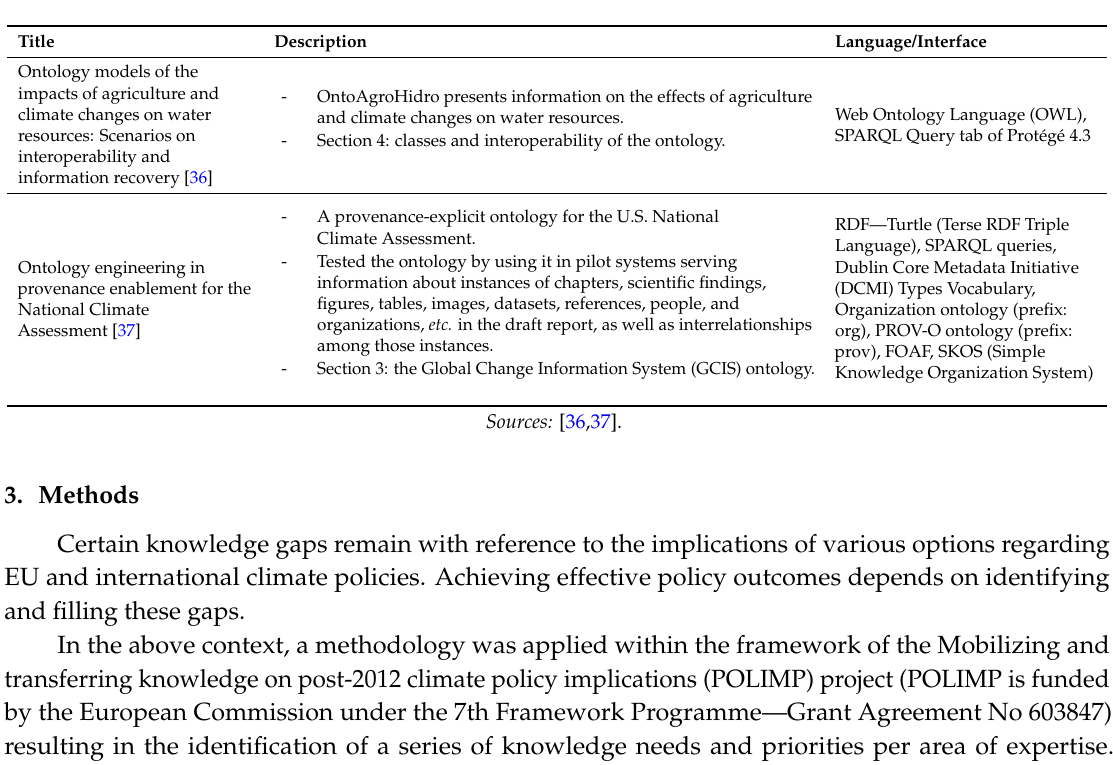
Table 2. Ontologies and Climate. Description Language/Interface